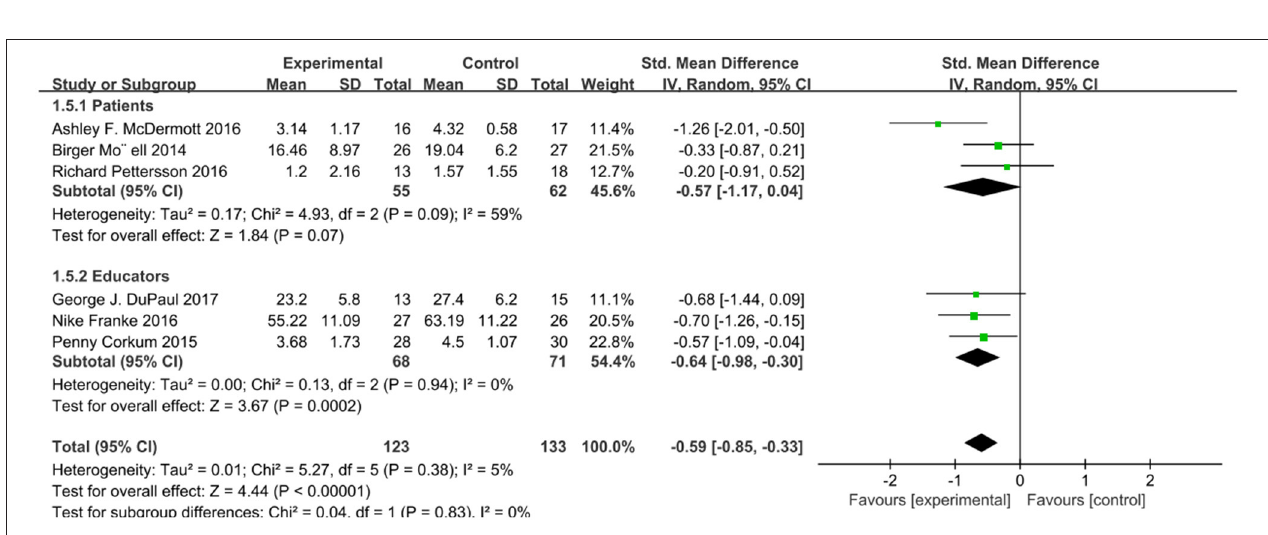
FIGURE 6 | Subgroup analysis of social function score of online intervention ADHD compared with waiting list (for patients or